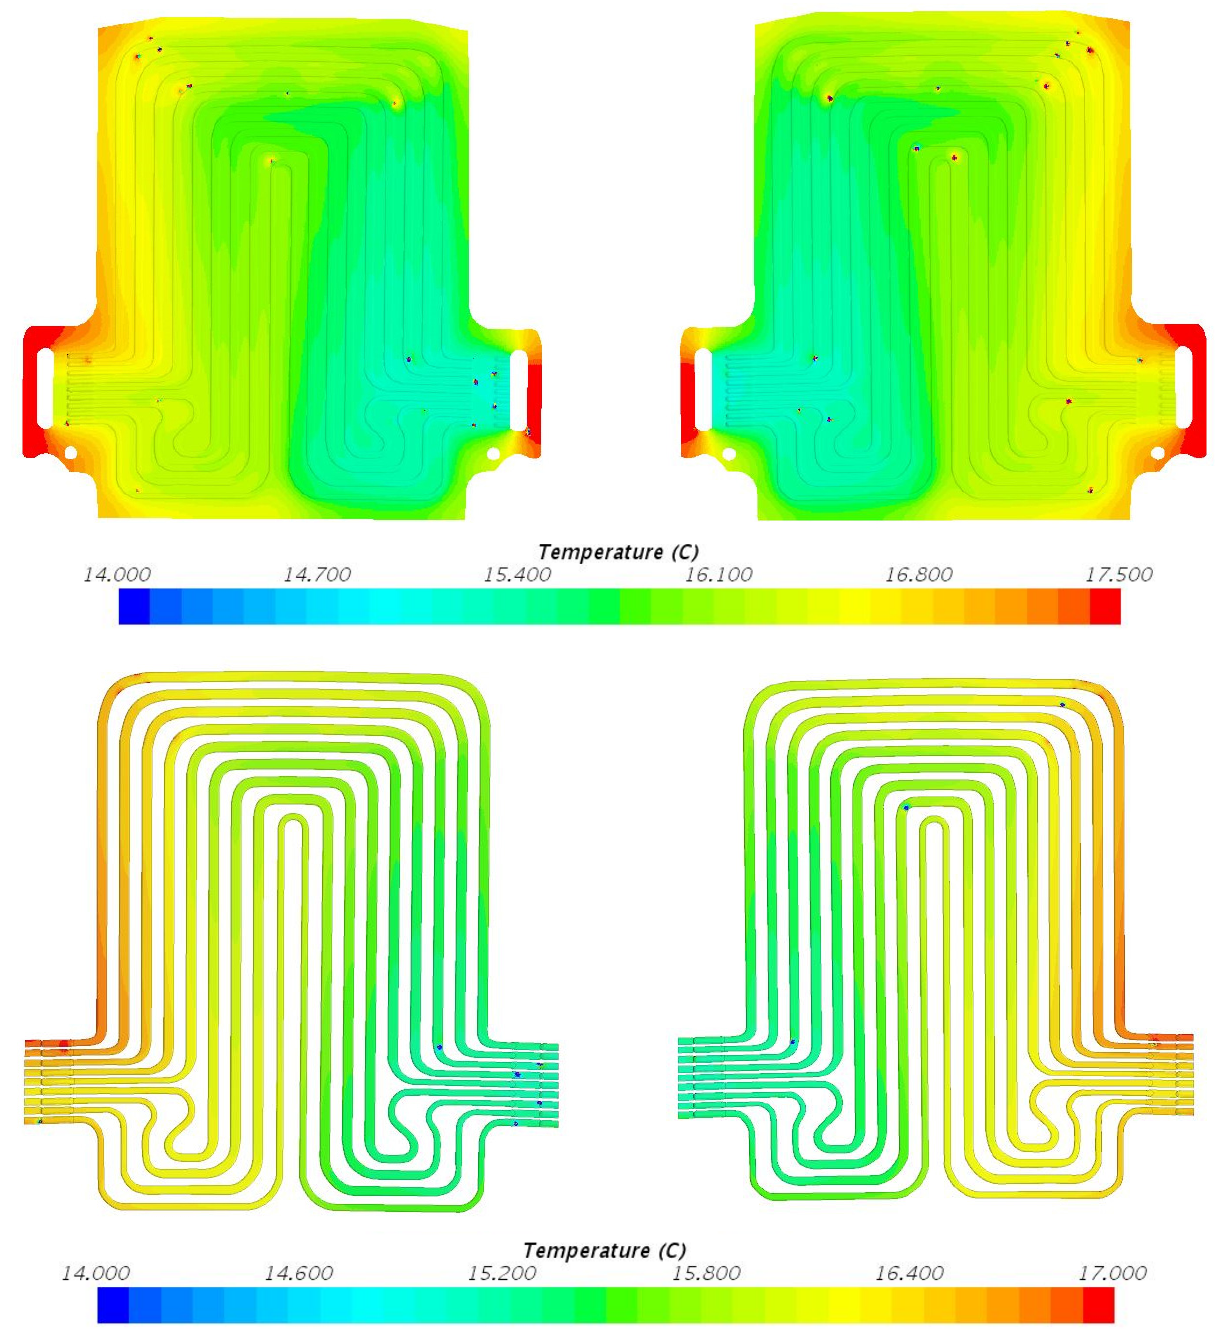
Figure 8. Temperature field at 20 A discharge current and 15 °C coolant inlet temperature with heat flux at position 1 = 475.7 W/m 2 , position 2 = 781.4 W/m 2 , and position 3 = 157.9 W/m 2 .